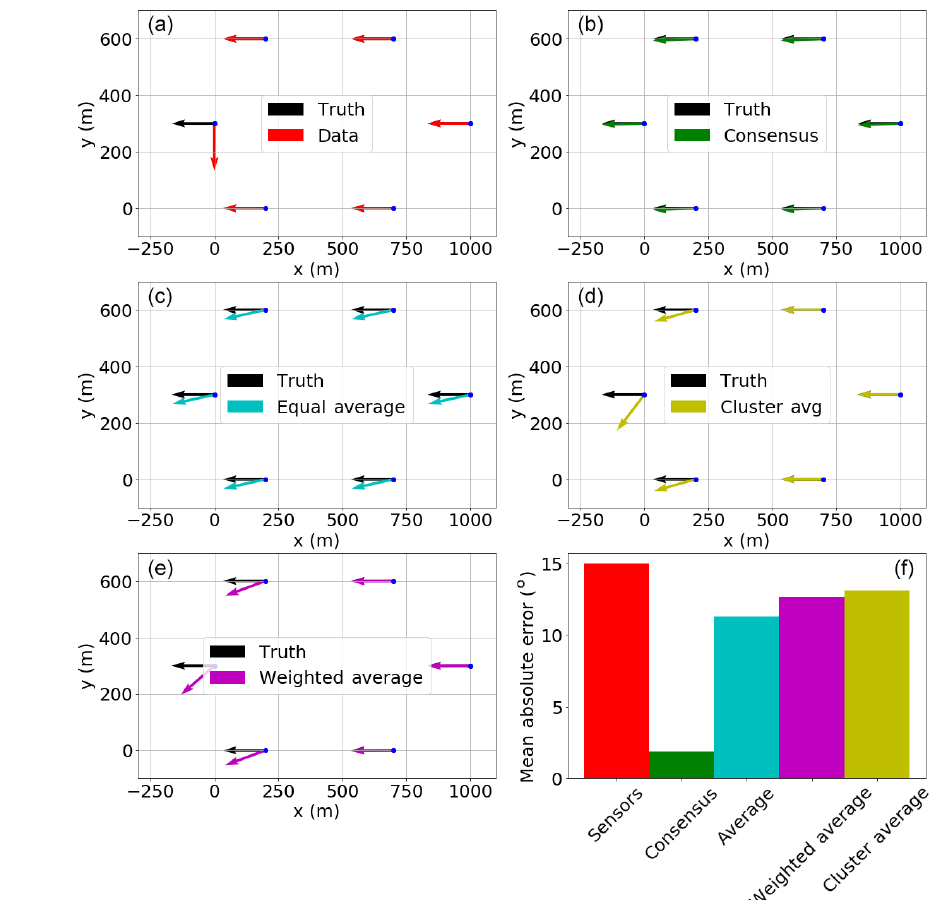
Figure 2. This six-turbine example demonstrates the effectiveness of the different methods in the presence of a fault in the Turbine 0 wind direction sensor. Panel (a) shows the “truth” data and the “measured” data. Note that the arrows are pointed in the upwind direction. Panel (b) shows the results of the consensus algorithm. Panel (c) shows the results of equal averaging across the wind farm. Panel (d) shows the cluster averaging approach and (e) shows the weighted averaging approach across the full wind farm. The mean absolute errors of each of the methods are shown in panel (f)